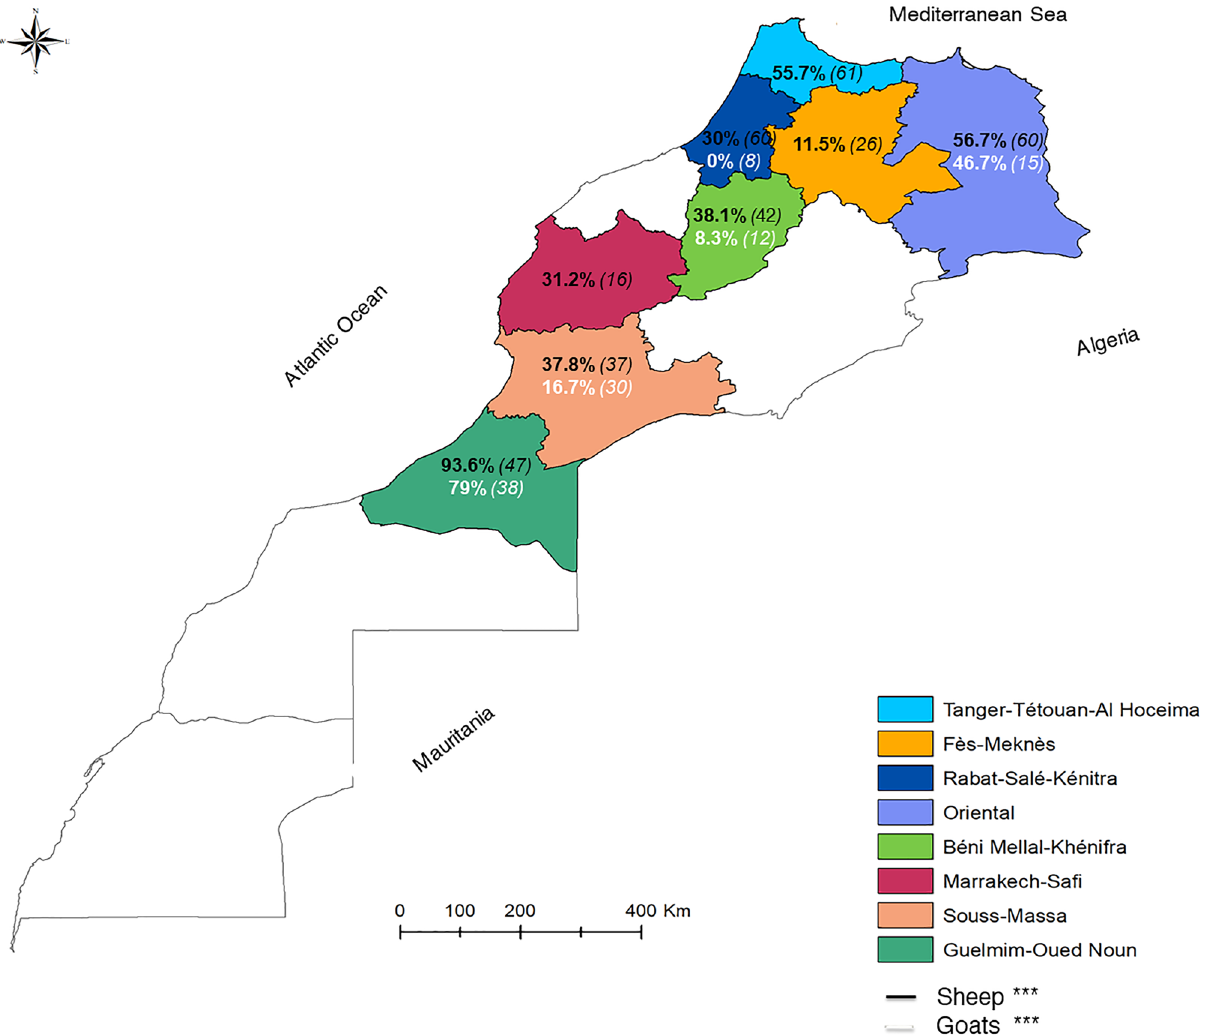
Figure 5. BTV viropositivity rates in sheep and goats during March 2018–July 2021 in Morocco. Black and white colors indicate BTV viropositivity rates in sheep and goats, respectively (in brackets, the number of samples screened). The statistical significance between rates is indicated as ***P <